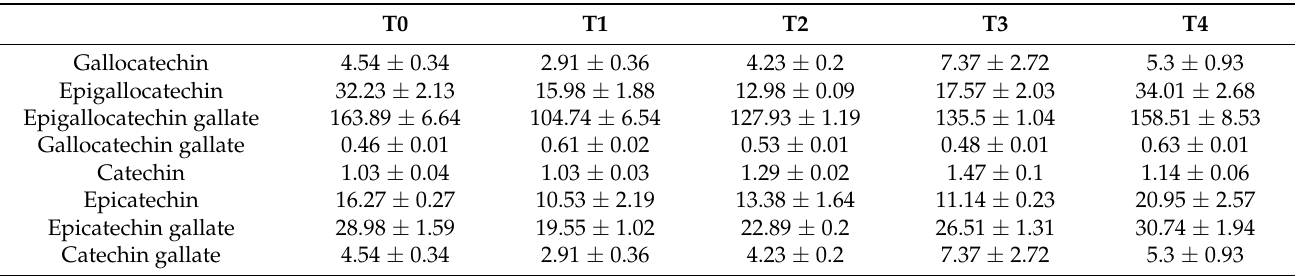
Table 3. Contents (mg g − 1 dry weight) of the main catechins in young tea shoots under different fertilization